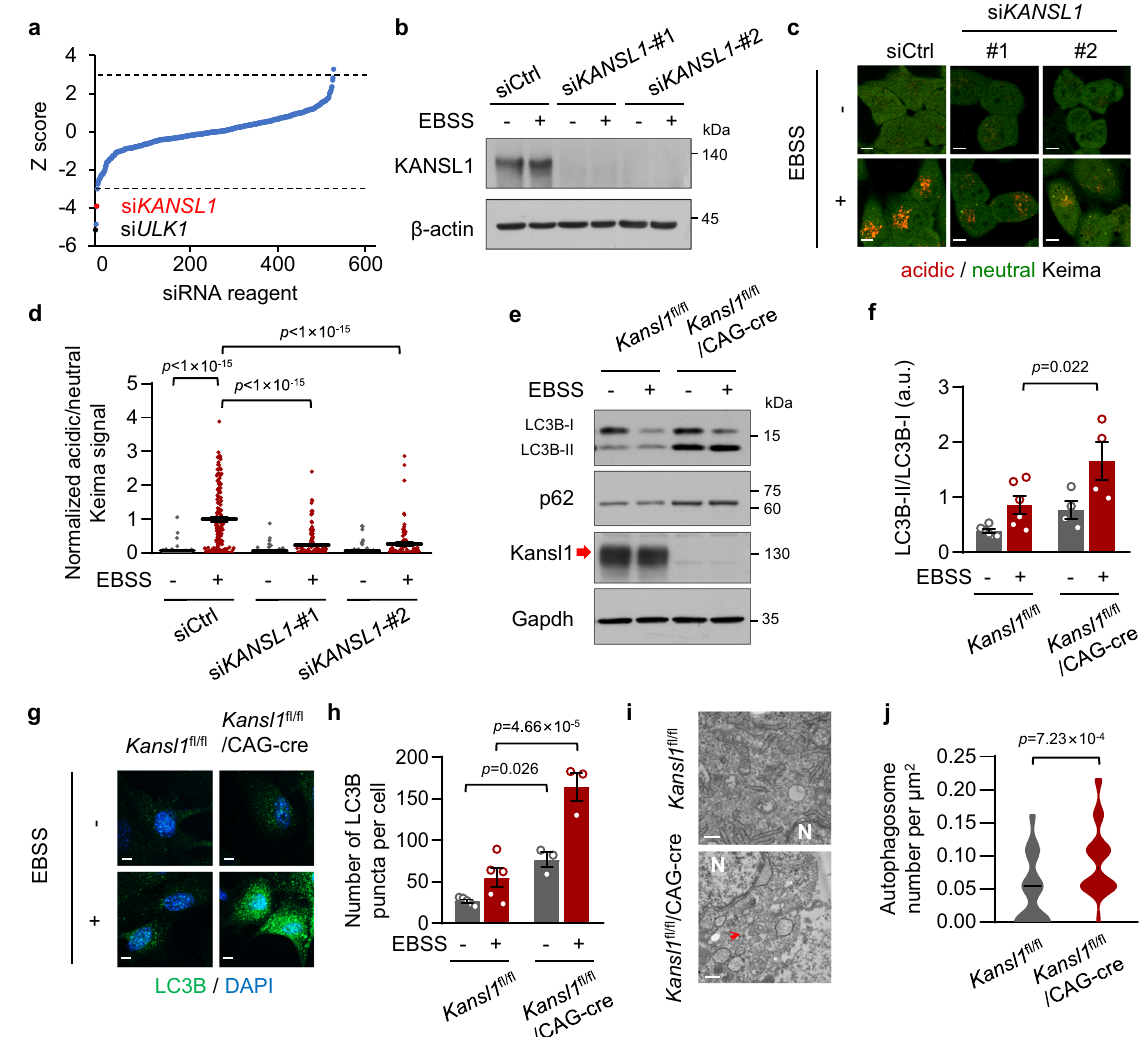
Fig. 1 KANSL1 is required for autophagy. a Graphical representation of the siRNA screen output. The ‘ Z-score ’ conveys the distribution of autophagic activity per well across the entire library (see details in “ Methods ” ). Dashed lines are screen-speci fi c cutoffs for active siRNA reagents. Black dots represent positive control siRNAs (si ULK1 ). b Western blot analysis of HeLa cells transfected with siRNAs after 12 h of EBSS treatment with the indicated antibodies. c Keima imaging in HeLa cells transfected with the indicated siRNAs after 12 h of EBSS treatment. The neutral Keima signal is excited at 458nm (green) and the acid Keima signal is excited at 561 nm (red). Scale bar, 10 μ m. d Quanti fi cation of Keima signal in ( c ). Values are normalized to the red/green signal in siCtrl with EBSS treatment group. Cells number was obtained from microscopy calculated for 45 to 157 from independent experiments. e Primary MEFs (tamoxifen treatment, 1 μ M, 48 h) were cultured with EBSS treatment for 6 h. Cell extracts were immunoblotted with the indicated antibodies. The arrow indicated the KANSL1 protein band. f Quantitation of protein signal intensities from immunoblots in ( e ) showing the ratio of LC3B-II to LC3B-I ( n = 6 Kansl1 fl / fl mice and 4 Kansl1 fl / fl /CAG-cre mice). g Representative immuno fl uorescence images of primary MEFs treated with 1 μ M tamoxifen for 48 h and cultured with or without EBSS treatment for 12 h. LC3B was detected as green fl uorescent signal and nuclei are labeled with DAPI (blue). Scale bar, 10 μ m. h Quanti fi cation of the number of LC3B puncta per cell in ( g ). n = 5 Kansl1 fl / fl mice and 3 Kansl1 fl / fl /CAG-cre mice. 25 – 72 cells were collected in each mouse. i Electron microscopy images of primary MEFs treated with 1 μ M tamoxifen for 48 h. N, nucleus. Arrows indicate autophagosomes. Scale bar, 500 nm. j Violin plot showing the number of autophagosomes per μ m 2 in ( i ). n = 33 Kansl1 fl / fl cells and 26 Kansl1 fl / fl /CAG-cre cells. Source data